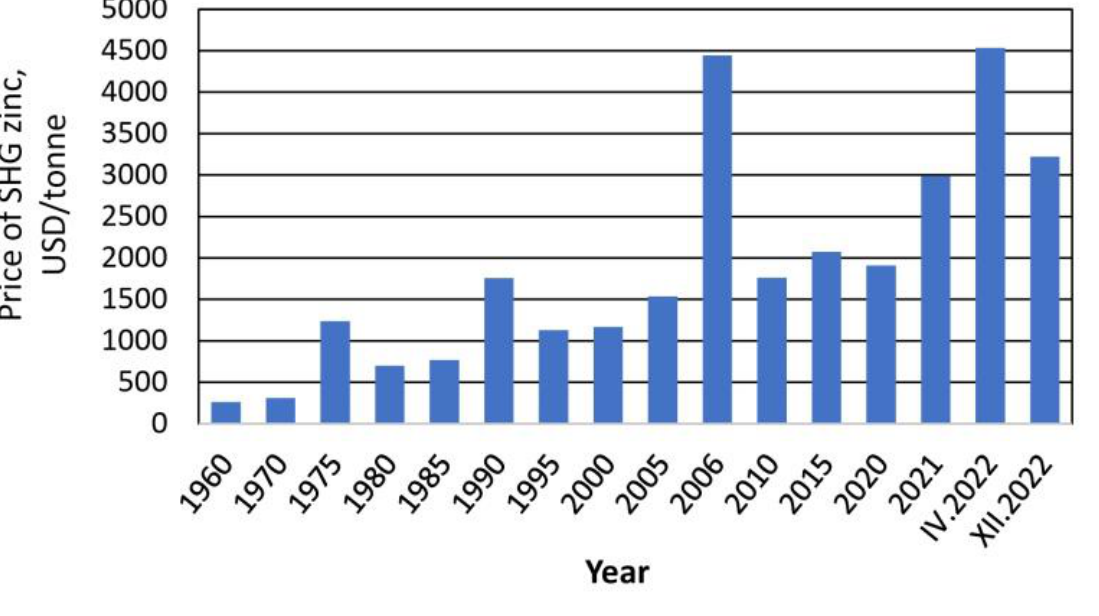
Figure 3. Zinc price in 1960 – 2022, figure prepared based on data from [32,33].